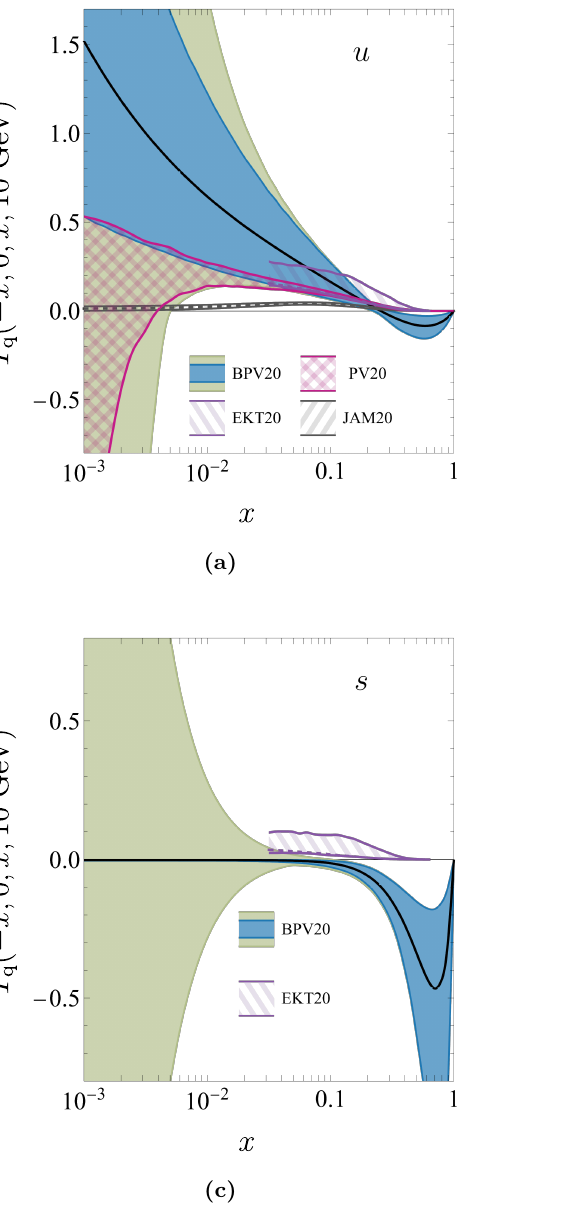
Figure 20. Qiu-Sterman function at µ = 10 GeV for different quark flavors, derived from the Sivers function (4.11). Our results are labeled as BPV20. The black line shows the CF value. Blue band shows 68%CI without gluon contribution added. The green band shows the band obtained by adding the gluon contribution estimated to be G (+) = ± ( | T results are compared to JAM20 [30] (gray dashed line with the error corridor hatched), PV20 [29] (magenta hatched region), EKT20 [31] (violet hatched region, dashed